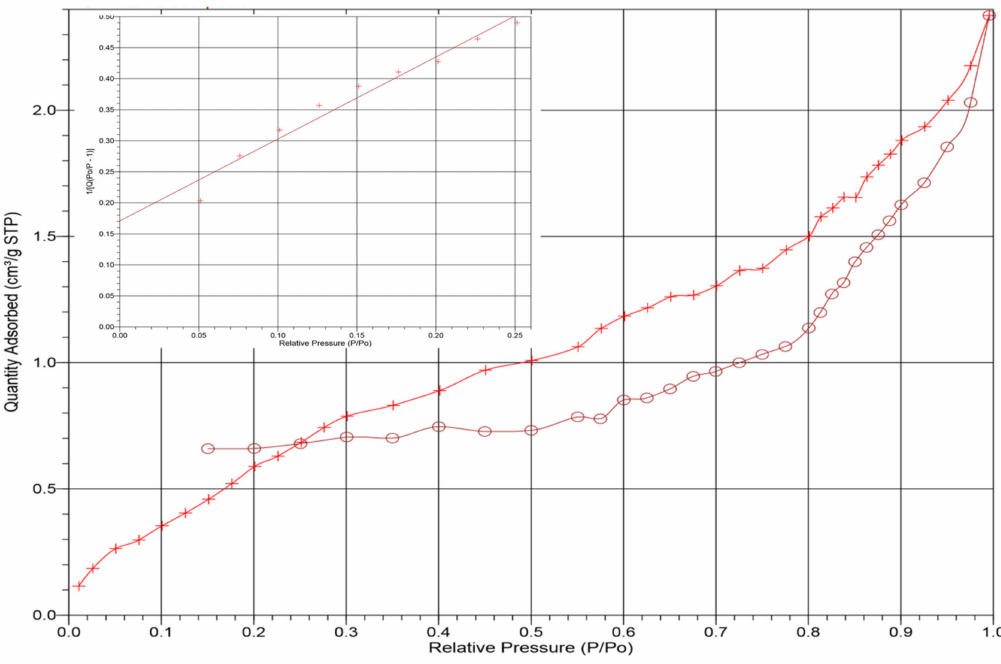
Figure 4. ADP linear isotherm plot with nitrogen adsorption plot (inset).